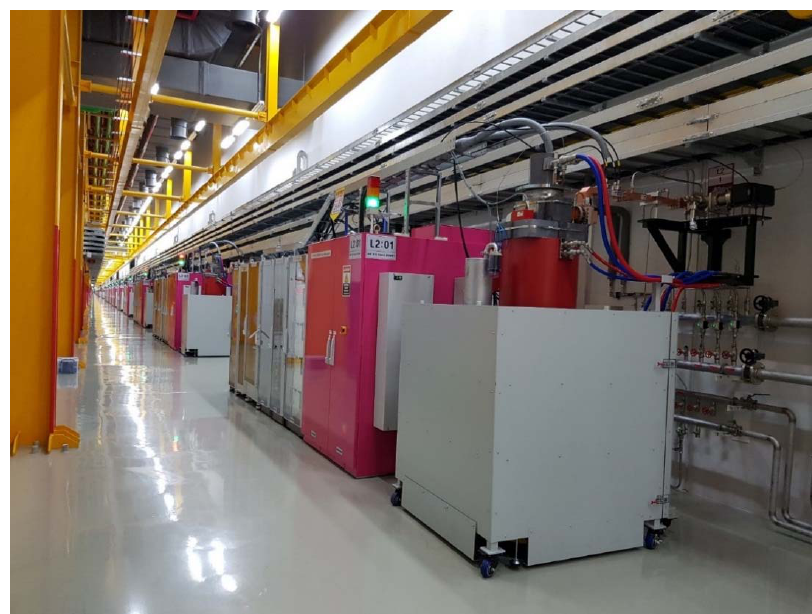
Figure 4. Klystron gallery of PAL ‐ XFEL.